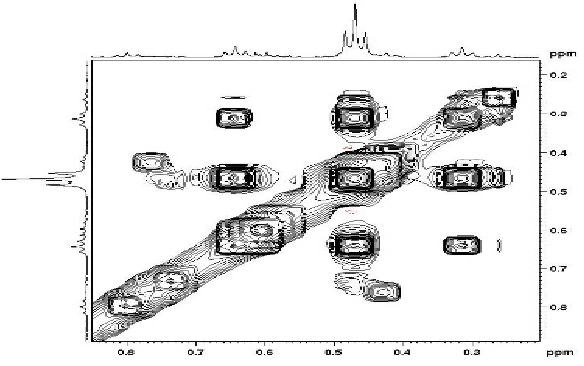
Figure 8. NOESY correlations between methyl groups in compounds 6 .